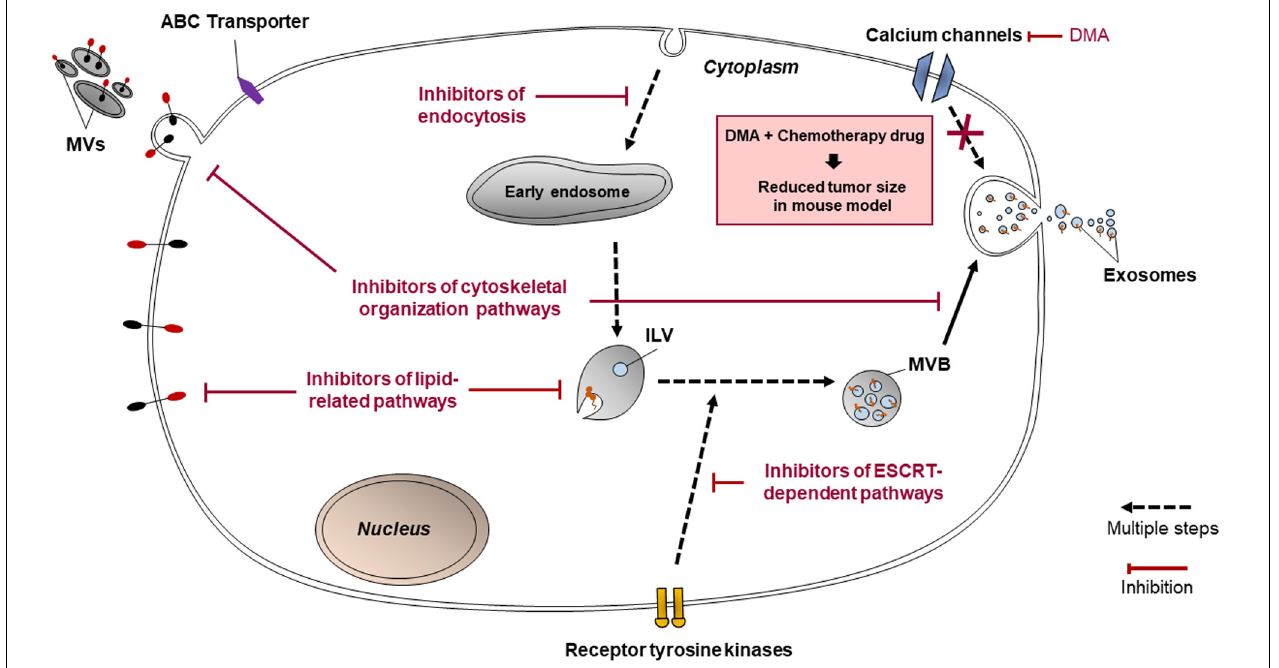
FIGURE 6 | Summary of possible targets for the inhibition of EV biogenesis, release, and uptake.